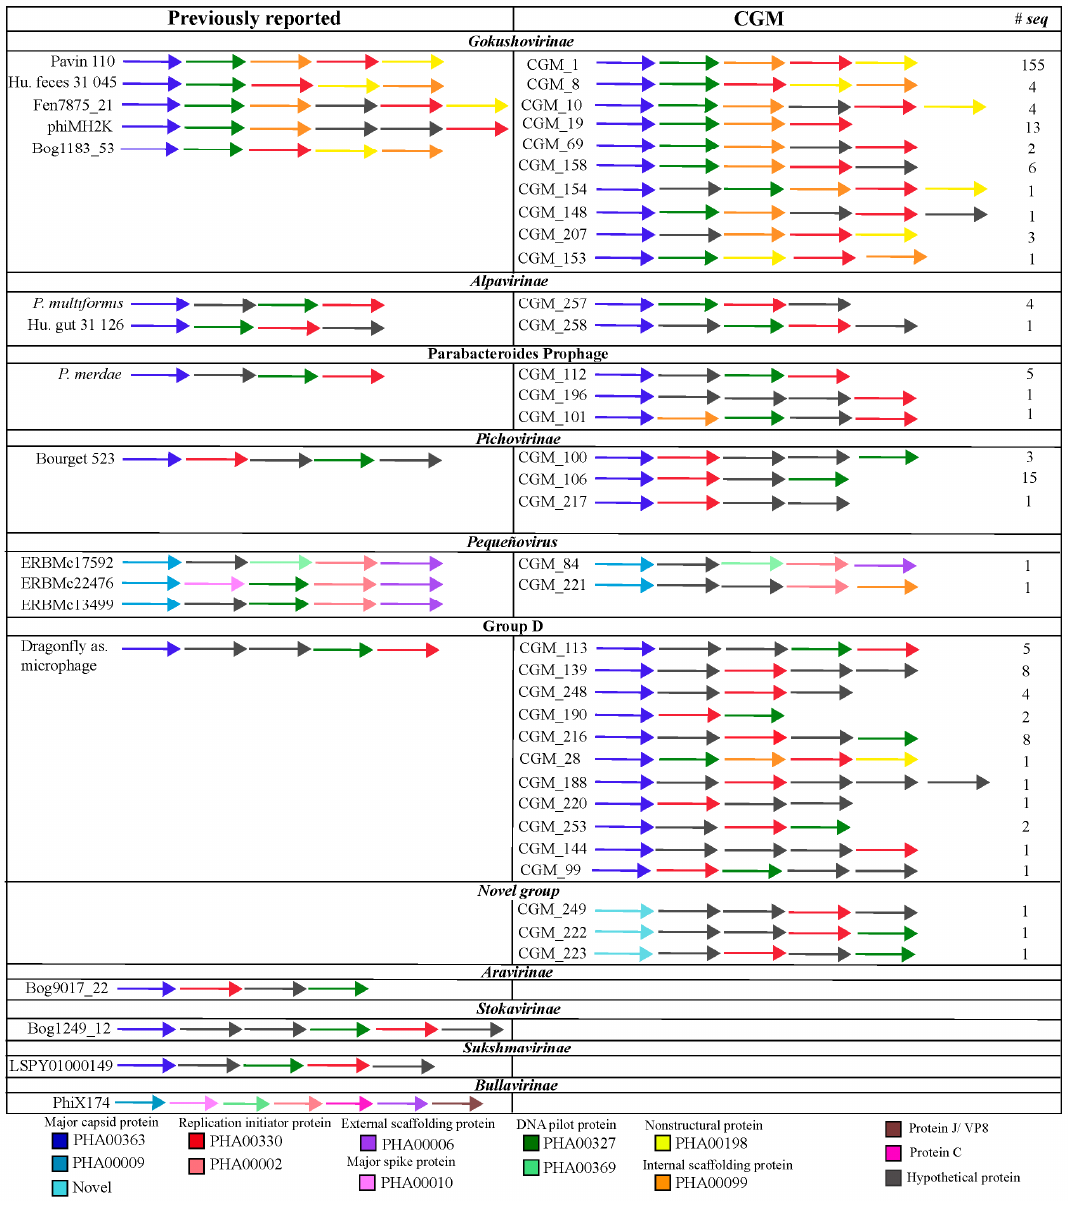
Figure 3. Gene synteny comparisons between previously described Microviridae genomes (left) and those discovered in the Ciona gut (right; CGM). All genomes were manually annotated to start at the major capsid protein (MCP) and open reading frames (ORFs) >80 aa are shown in linear fashion (i.e., overlapping genes are shown in order based on the position of the start codon). ORFs are color-coded based on PHA numbers (the phage protein subset of the Entrez protein cluster (PRK) database). One representative of each gene order known to exist within a given (proposed) subfamily is shown, and the numbers of CGM genomes containing a particular gene order are specified on the far right. The novel CGM group does not have representatives in the database, while the Aravirinae, Stokavirinae, Sukshmavirinae, and Bullavirinae were not detected among the CGM sequences. Details on the gene order for each CGM genome are available in Supplementary Table S2.